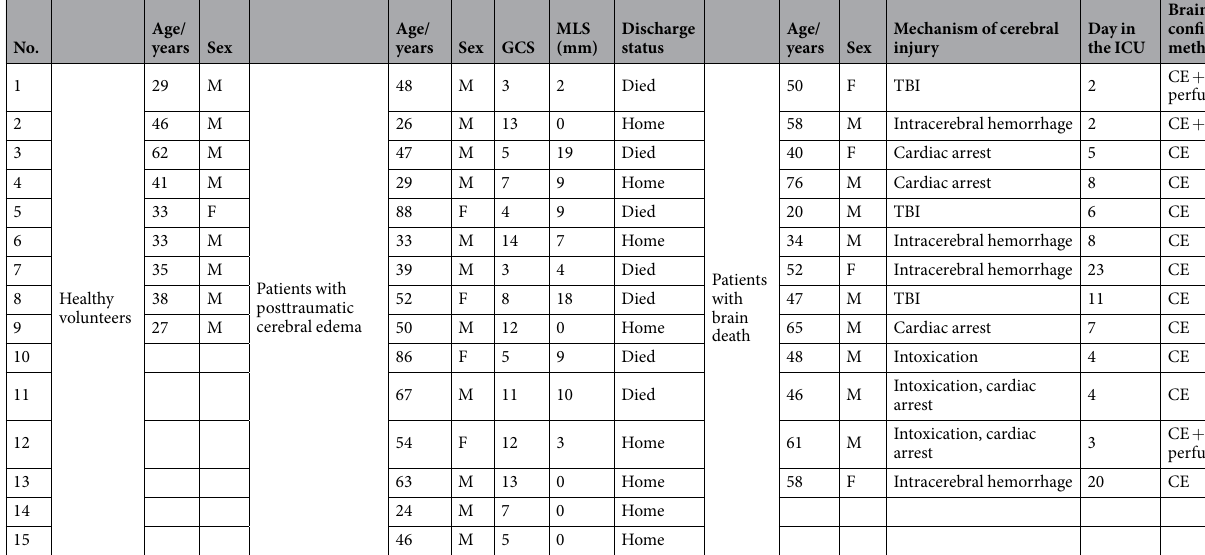
Table 1. Baseline demographic and clinical characteristics of study groups. No. - patient number, M - male, F - female, GCS - Glasgow Coma Scale score on admission, MLS – midline shift assessed from CT scan, TBI - traumatic brain injury, CE - clinical evaluation, CT - computed tomography, TCD- transcranial Doppler. Cerebral edema group was characterized in details previously 34